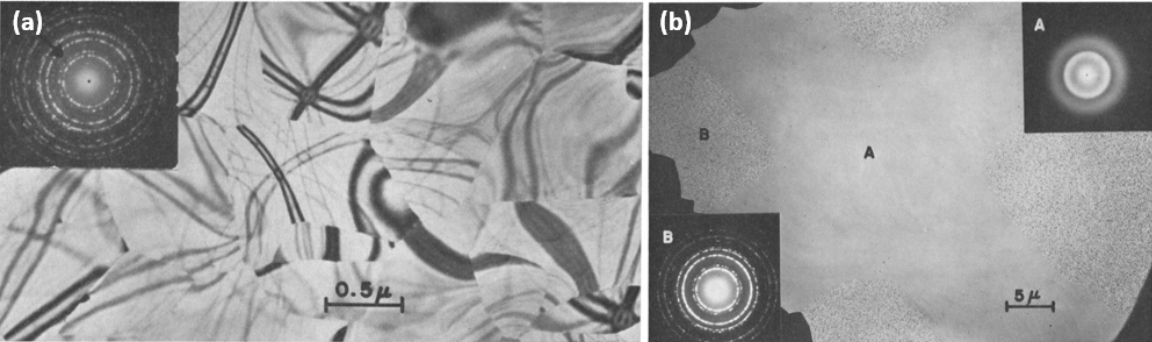
Figure 2. TEM images and inset SAED patterns of ( a ) fully crystallized ZrO 2 produced by TEM in situ pulse heating; ( b ) amorphous ZrO 2 film irradiated with 20 keV Kr ions to a fluence of 9 × 10 15 ions/cm 2 through a 400-mesh Cu grid with a 5 µA/cm 2 flux; the region shielded by the mesh (inset image marked ‘A’) remained amorphous, while the unshielded region bombarded by ions (inset image marked ‘B’) underwent an a-to-c transformation. Reproduced with permission from ref. [48].